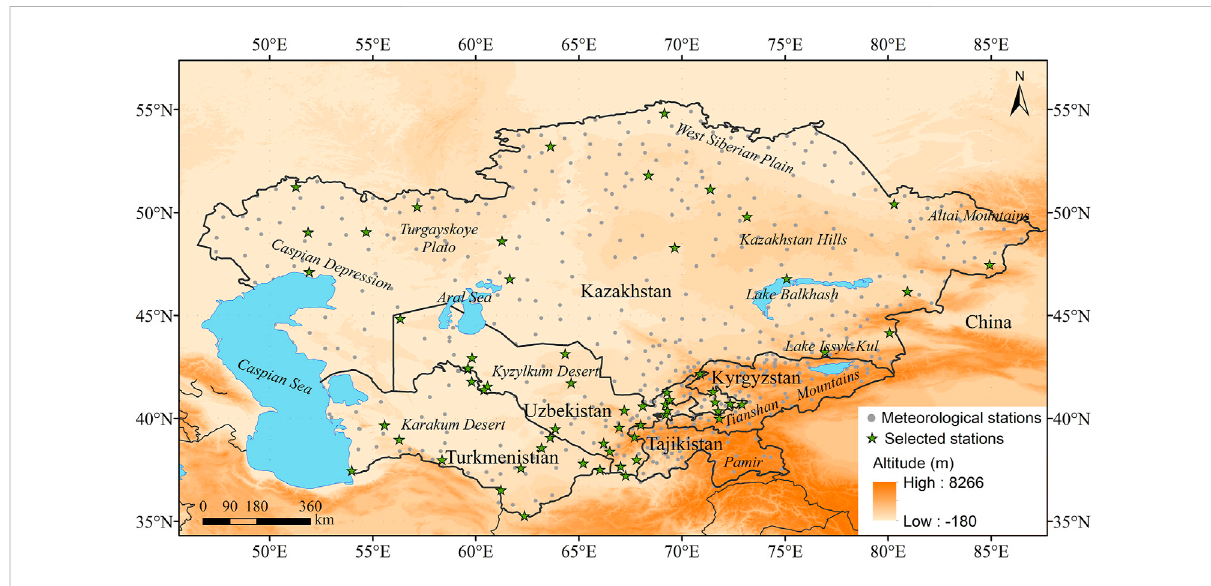
FIGURE 1 Topography map of Central Asia with the location of meteorological